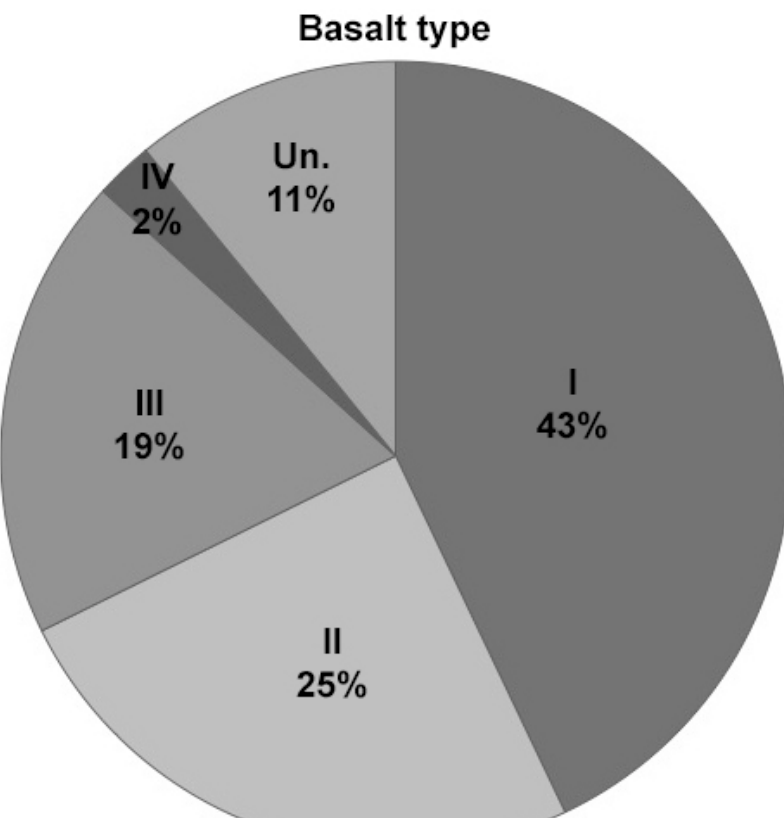
Figure 3: Raw material frequencies of basalt types in the Shubayqa 1 assemblage. The divisions were based on macroscopic observations (see Table